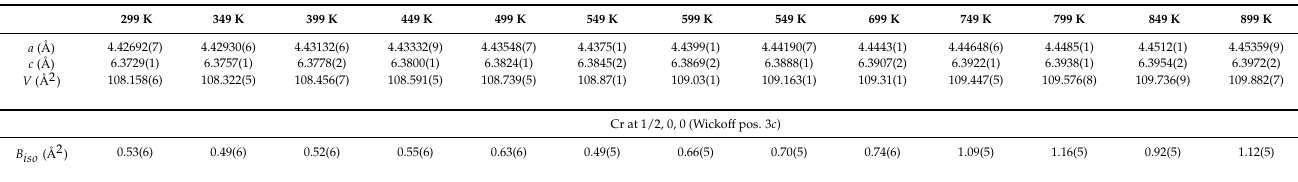
Table A2. Rietveld refined lattice and structural parameters for CrSi 2 at 299 K, 349 K, 399 K, 449 K, 499 K, 549 K, 599 K, 649 K, 799 K, 849 K, and 899